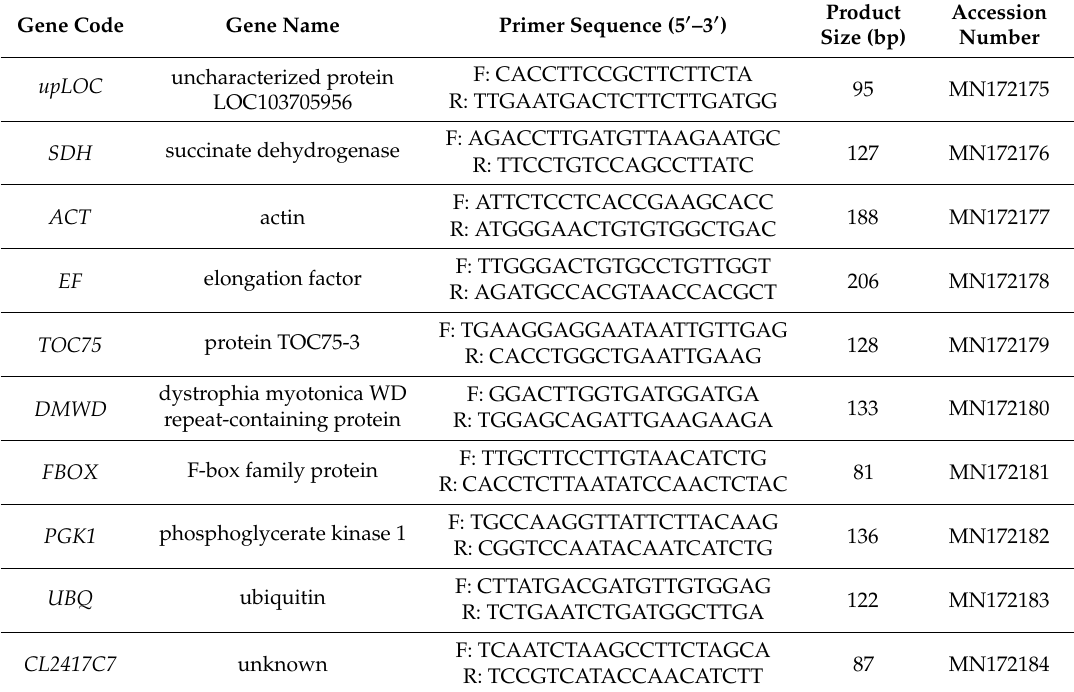
Table 2. Reference genes and their primers in this